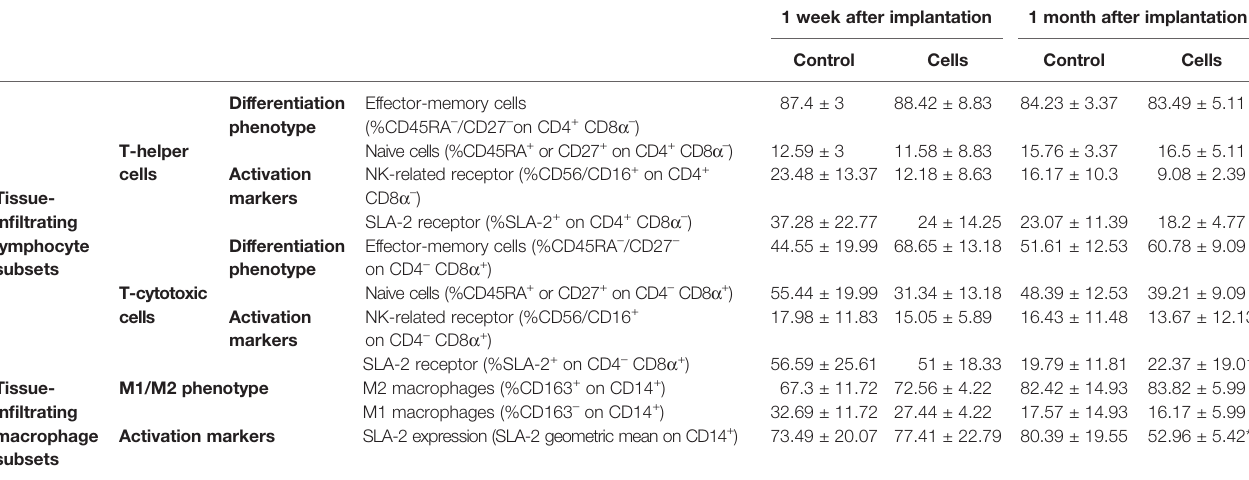
TABLE 4 | Results of the phenotypic analysis by fl ow cytometry of the in fi ltrated lymphocytes and macrophages inside the surgical meshes 1 week and 1 month after implantation surgery.